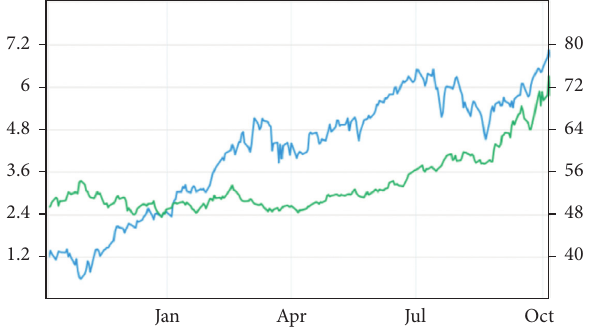
Figure 3: The trends of some influencing factors for the gold price. Table 1: Correlations.